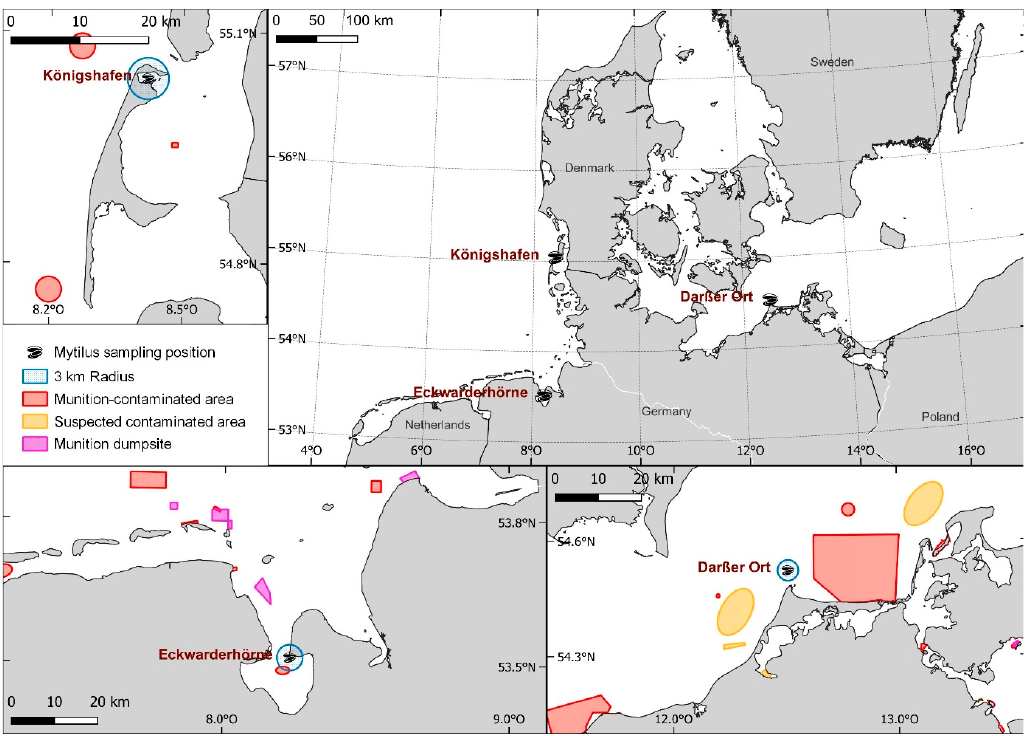
Figure 1. Map of the Mytilus sampling areas of the Environmental Specimen Bank: “Königshafen” on the island of Sylt (N55°2.3, E8°25.5), “Eckwarderhörne” (N53°31.2, E8°13.8) in the German North Sea, and “Darßer Ort” (N54°29.7, E12°31.6) in the Baltic. The o ffi cially known dumpsites, munition- contaminated areas, and suspected areas are shown as colored spaces (data provided by amucad.org). A 3 km radius was drawn around the sampling positions to show their proximity to possible munition deposits.